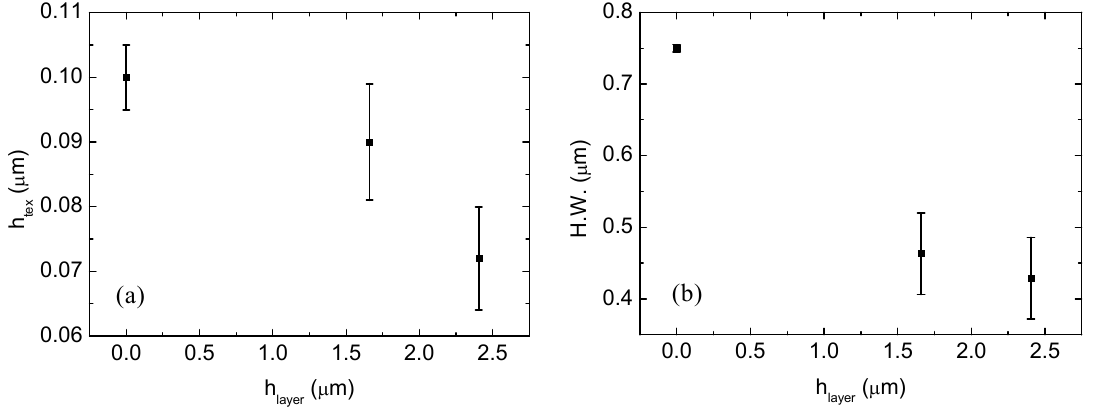
Figure 6. Experimental data for the grating height ( a ) and hole width parameters ( b ) obtained from the AFM image